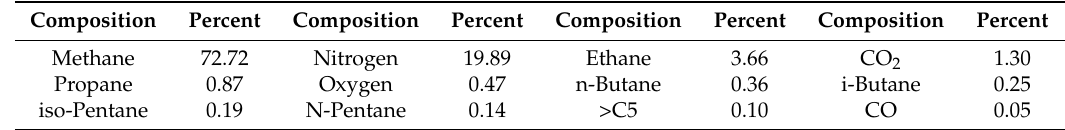
Table 3. Compositions of transmission gas (vol.%).